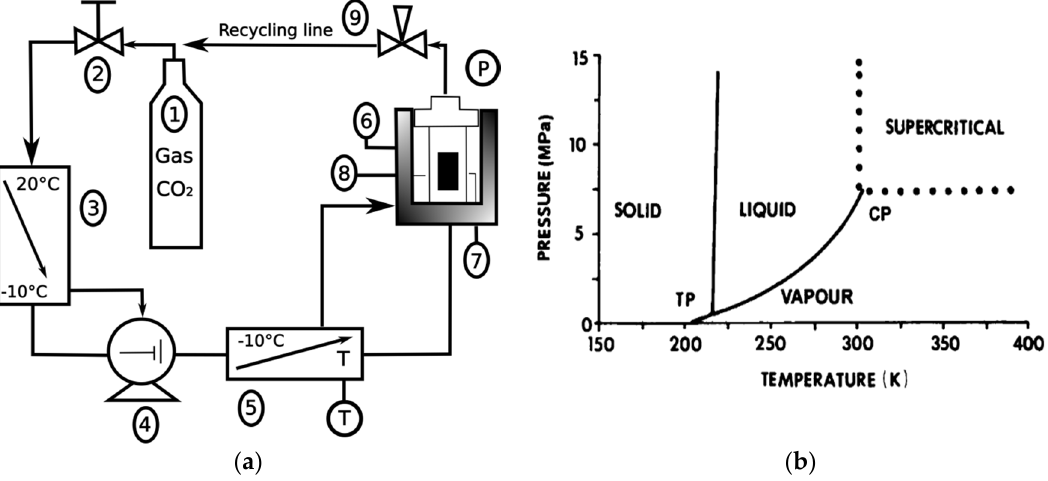
Figure 2. ( a ) Diagram of the supercritical debinding equipment [10]; ( b ) Carbon dioxide pressure- temperature phase diagram, showing the triple point (TP) and critical point (CP)